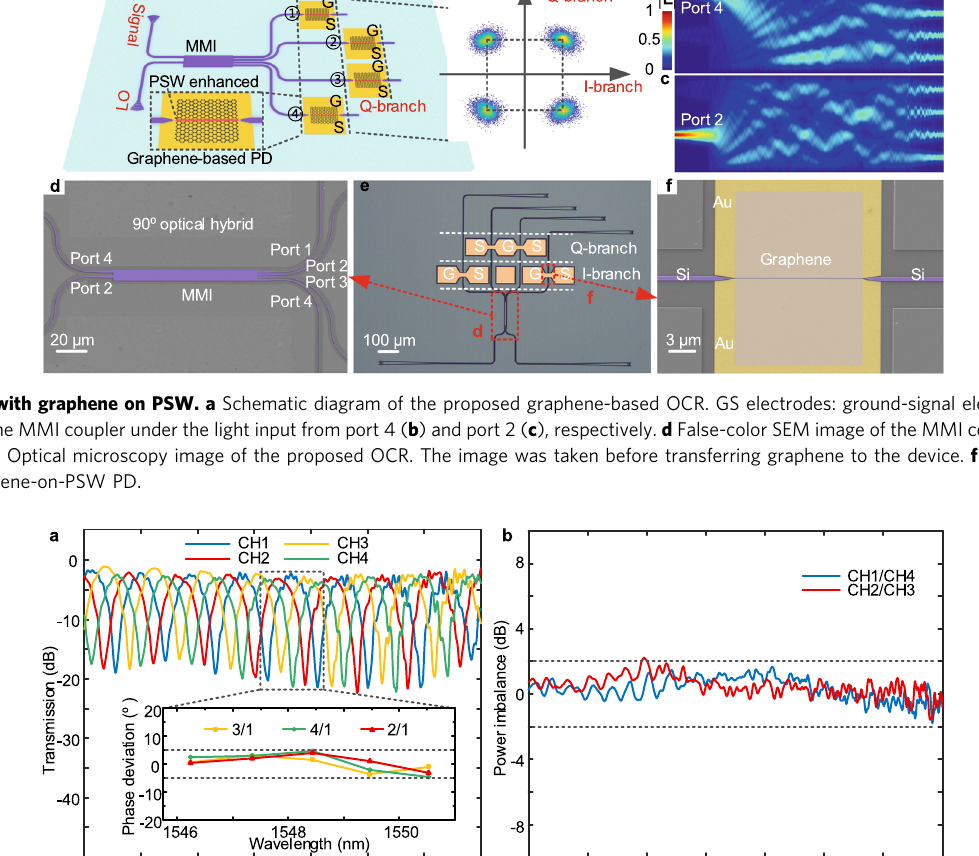
Fig. 3a. The responsivity of either PD is close to 0.1 A/W at the − 0.3 V-bias voltage. The lines in Supplementary Fig. 9 show that